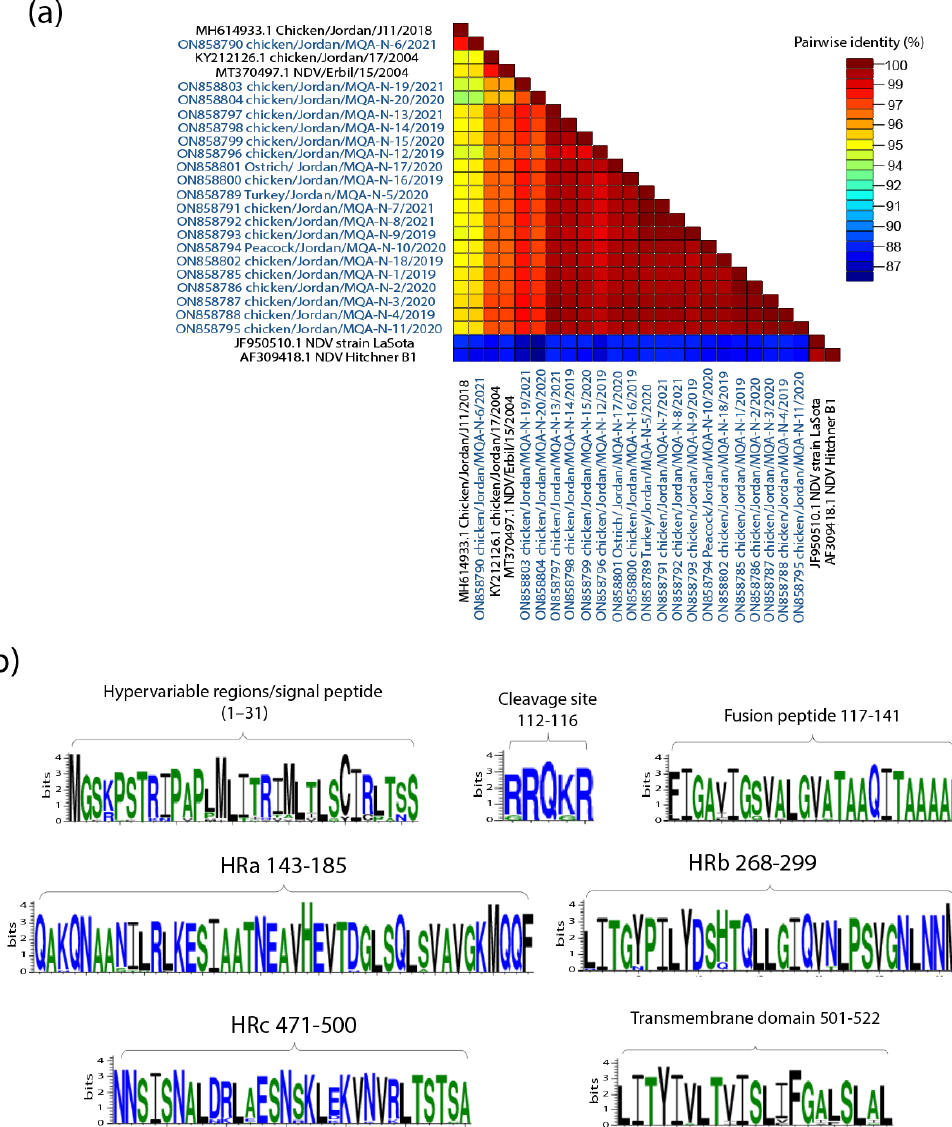
Figure 4. ( a ) The pairwise identities plot of fusion protein sequences aligned by MAFFT and displayed by Sequence Demarcation Tool (SDT) software. ( b ) WebLogo graphs illustrating the amino acid divergence between AOAVv-1 isolates reported in this study compared to LaSota vaccine and previously reported isolates in Jordan.